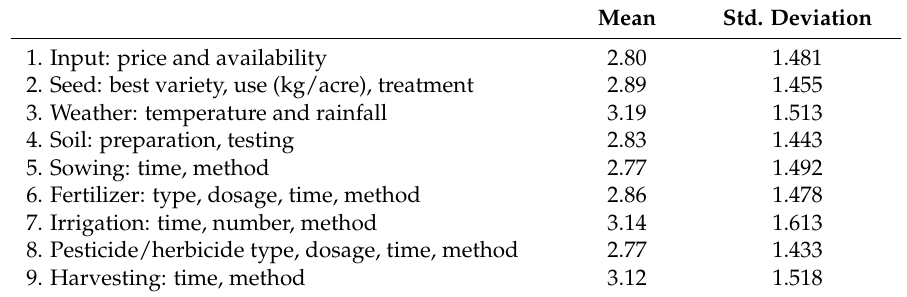
Table A1. Descriptive statistics of farmers’ access to different types of production information.